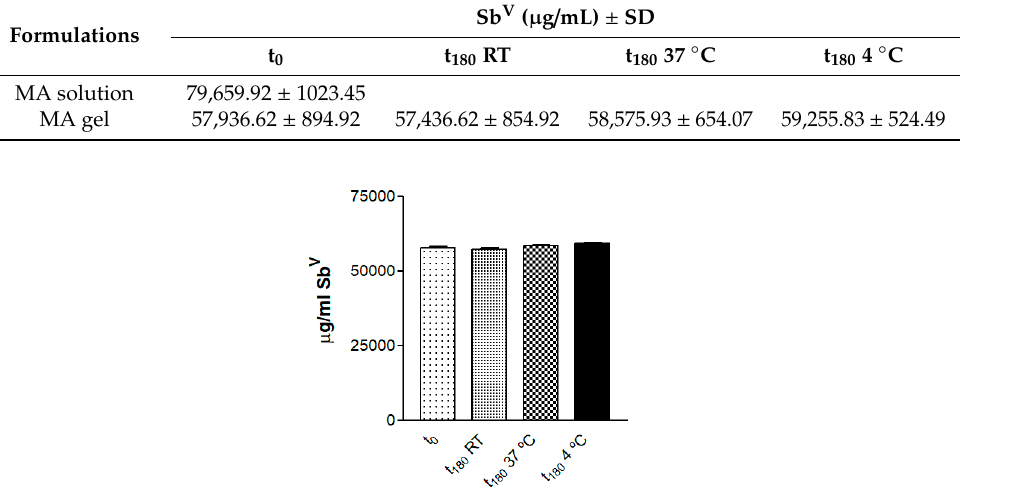
Figure 3. Concentration of Sb V in the gel at different storage temperatures at the beginning of the experiment and 6 months later.